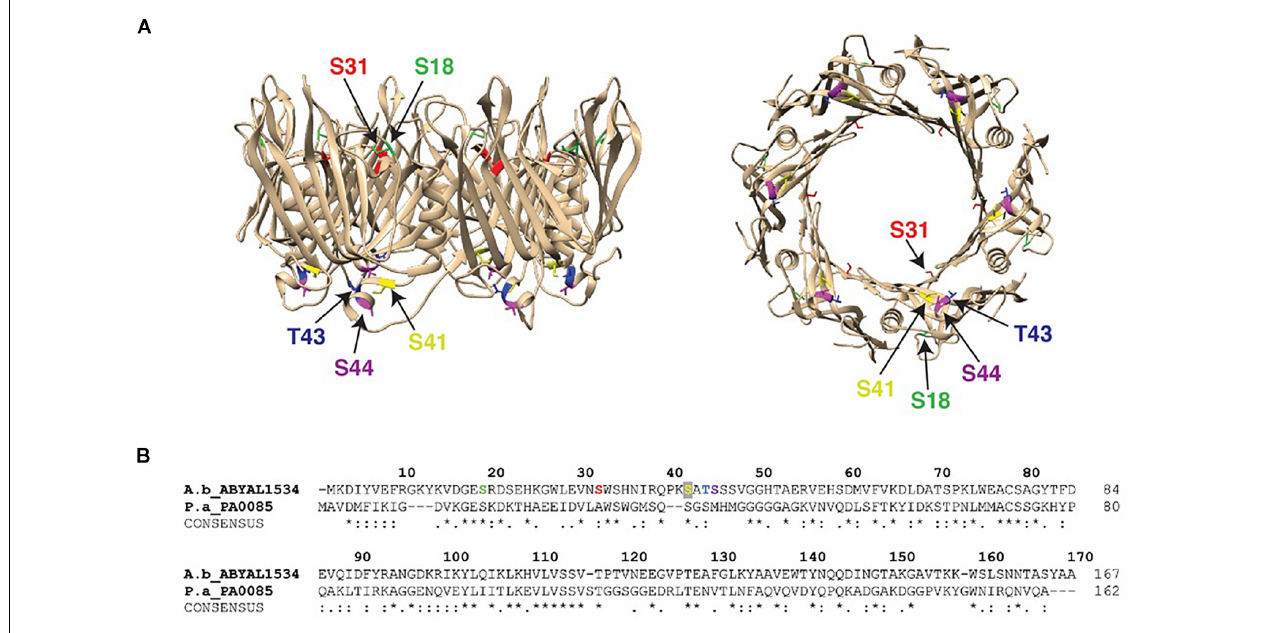
FIGURE 2 | Hcp phosphorylation sites: (A) Crystal structure of the A. baumannii Hcp (PDB 4W64) with specific phosphosites colored (S18, light green; S31, red; S41, yellow; T43, blue; S44, purple) and the Hcp hexameric donut structure viewed from the side (left) and bottom (right). (B) Alignment of Hcp protein from A. baumannii ATCC 17978 (A.b_ABYAL1534) and P. aeruginosa (P.a_PA0085). Completely invariant residues are indicated with an asterisk (*), highly conserved regions are marked with a colon (:) and semi-conserved residues are dotted (.). Identified peptides and phosphosites in our study are colored and designated by